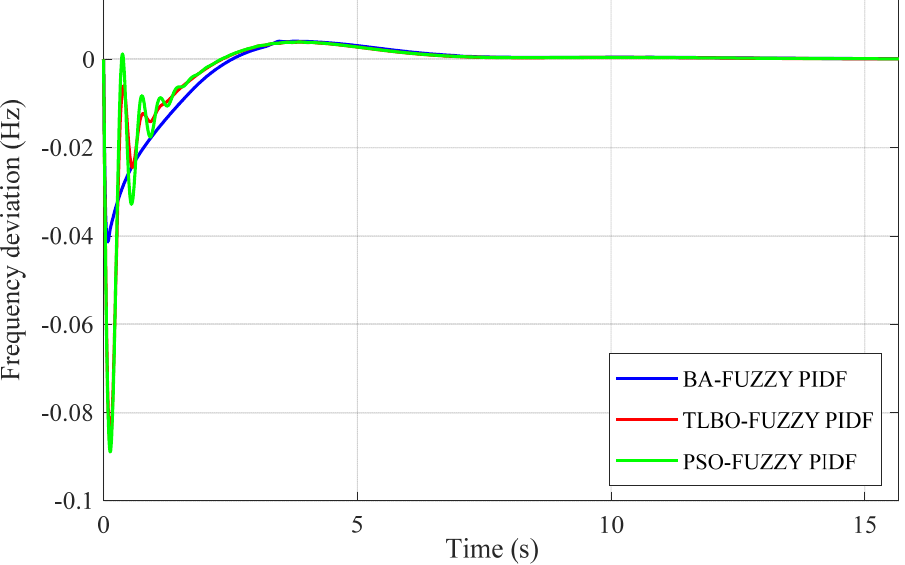
Figure 18. Frequency deviation in area 1 ( ∆ F 1 ).